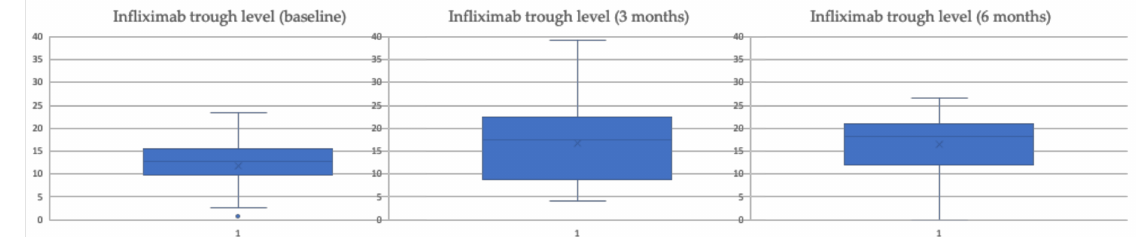
Figure 2. Trends in serum infliximab concentrations [ µ g/dl] intensified patients.